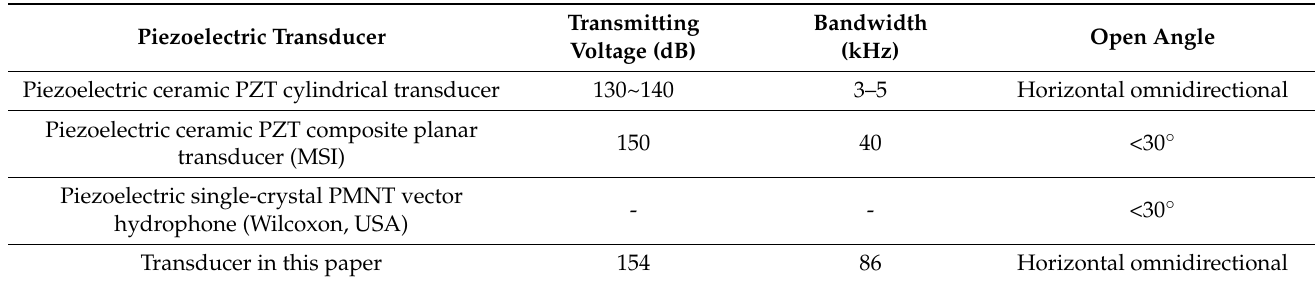
Table 1. Comparison of various types of